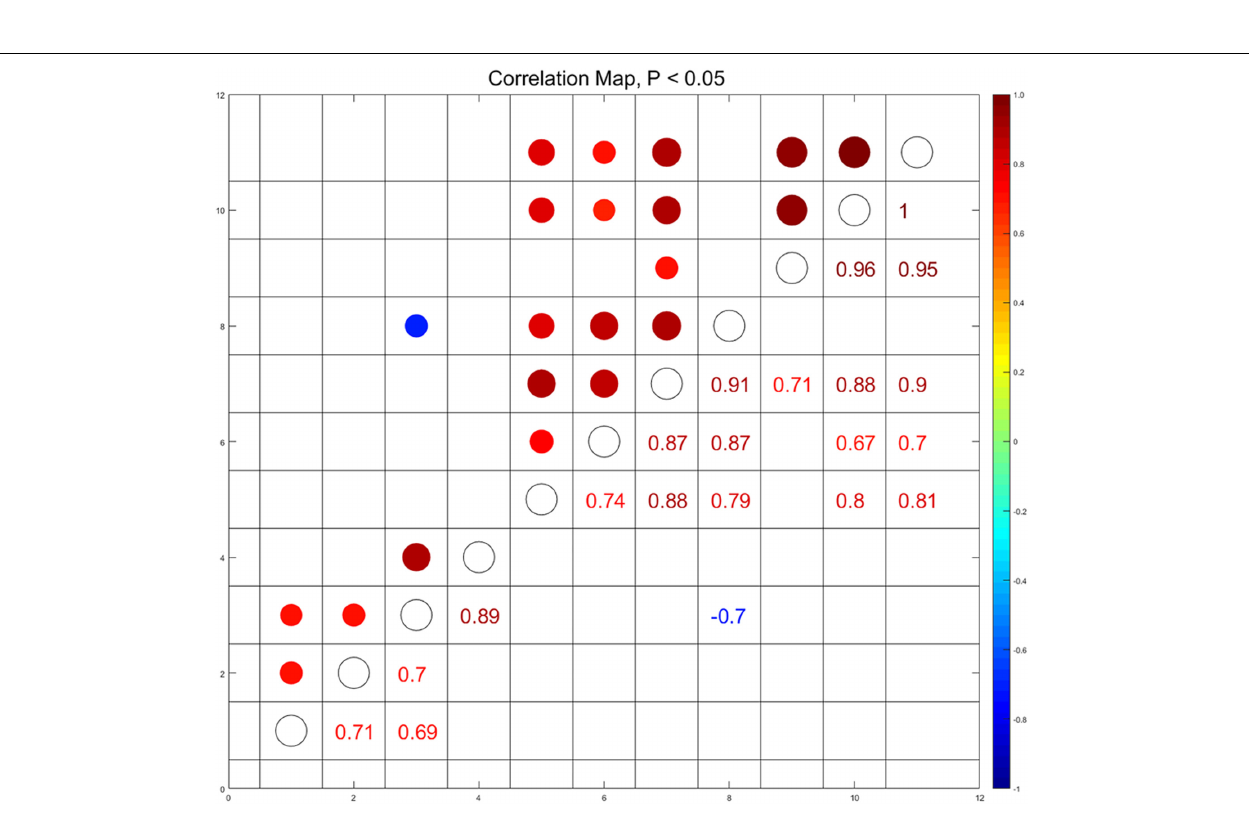
Frontiers in Molecular Neuroscience |